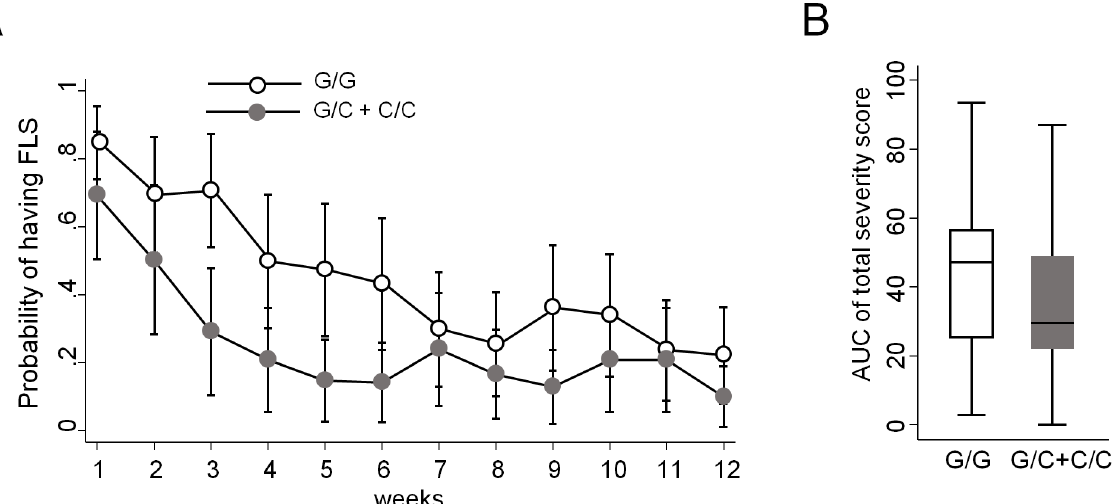
Fig 2. FLS probability and severity. (A) Probability to develop FLS calculated during the follow-up of 12 weeks in patients bearing at least one allele with a C at position -174 of IL-6 gene and in those bearing only the allele with the G at the same position. (B) Area under the curve (AUC), calculated as the total symptoms scores that were self-reported after each injection in patients bearing at least one allele with a C at position -174 of IL-6 gene and in those bearing only the G allele at the same position.